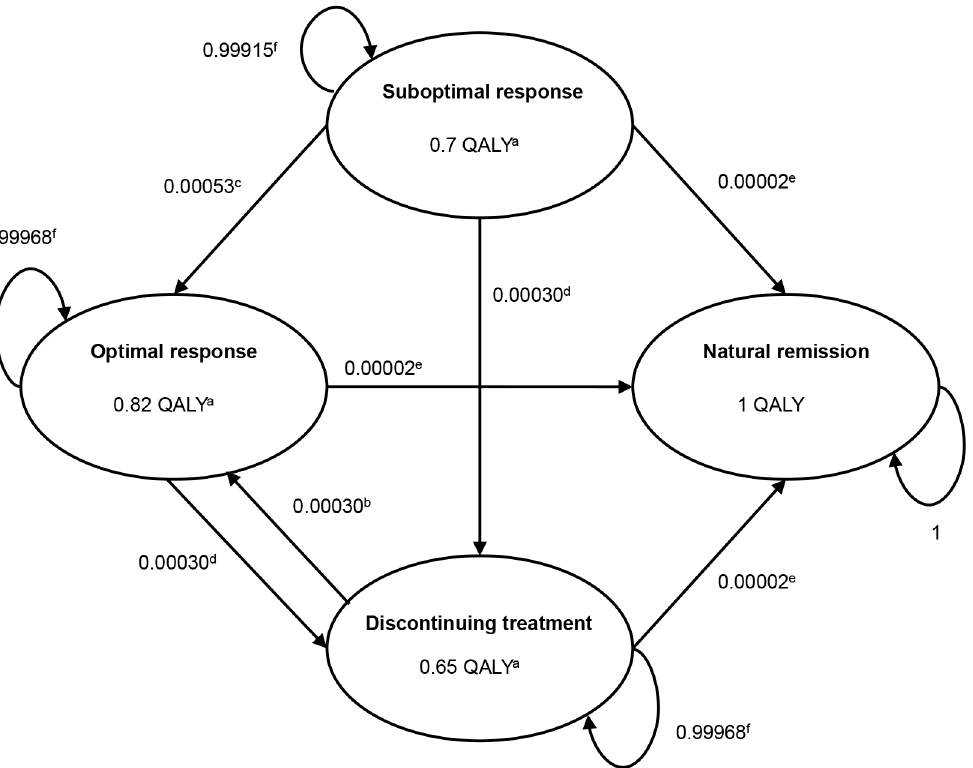
Fig 2. Markov model IR-MPH treatment with daily transition probabilities and utilities on an annual basis (QALY). QALY = Quality adjusted life years a Source: Lloyd et al. (2011) [19] b Source: Wong et al. (2009) [18] c Source: Expert panel Faber et al. (2008) [2] d Source: Faber et al. (2008) [2] e Source: Biederman et al. (2000) [20] f Source: Remaining